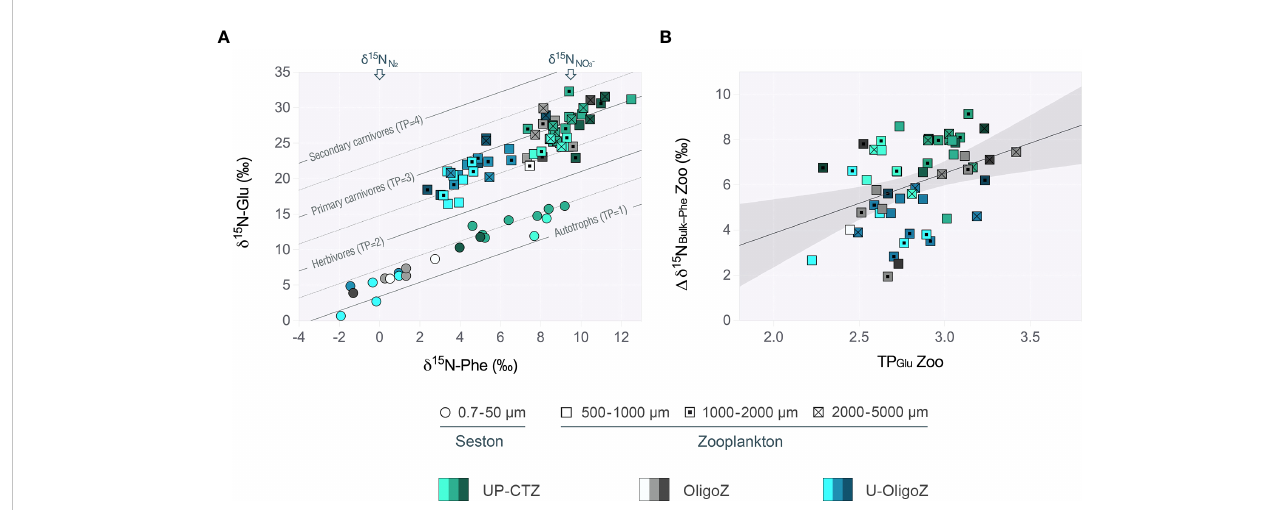
FIGURE 4 (A) Cross-plot for d 15 N values of Glu and Phe of seston and size-fractionated zooplankton measured at the upwelling-coastal transition (UP-CTZ), the oligotrophic (OligoZ) and the ultra-oligotrophic (U-OligoZ) regions from the Southeast Paci fi c. The color gradient stands for the depth layer, including epipelagic (bright tones), mesopelagic (half-tones) and bathypelagic waters (dark tones). The amino acid isotope compositions in the samples are arrayed across trophic isoclines representing various trophic positions (TP=1, 2, 3, and 4, plotted as solid lines). Above are given the reference d 15 N values for atmospheric N 2 (0 ‰ ) and NO − 3 (mean value of 9.3±2.7 ‰ , considering the range of d 15 N NO − O − 3 concentrations). (B) Trophic enrichment in zooplankton from all different habitats of the Southeast Paci line between d 15 N xtBulk - Phe and TP Glu ( Dd 15 N Bulk-Phe = 2.66 TP Glu - 1.47, R 2 = 0.16, P value = 0.003, n = 54). Shadow grey bands stand for the 95% con fi dence intervals.